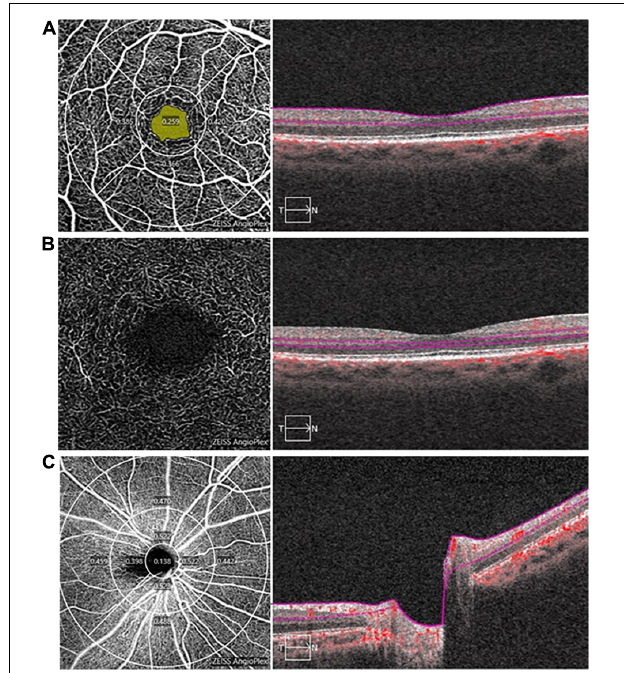
FIGURE 1 | Image analysis of optical coherence tomography angiography (OCTA). (A) The superficial capillary plexus (SCP) map in the macula (3 mm × 3 mm), a 1 mm diameter circle and a 3 mm diameter circle divide the SCP into a central area and an inner-circle area, the yellow area is foveal avascular zone (FAZ), the right panel shows a typical segmentation from the inner limiting membrane to the inner plexiform layer; (B) The deep capillary plexus (DCP) map in the macula (3 mm × 3 mm), the right panel shows a typical segmentation from the inner nuclear layer to the outer plexiform layer; and (C) The radial peripapillary capillary (RPC) map (6 mm × 6 mm), 1, 3, and 6 mm diameter circle divide the RPC into a central, inner-circle and outer-circle area, the right panel shows a typical segmentation of optic nerve head from the inner limiting membrane to the inner plexiform layer.